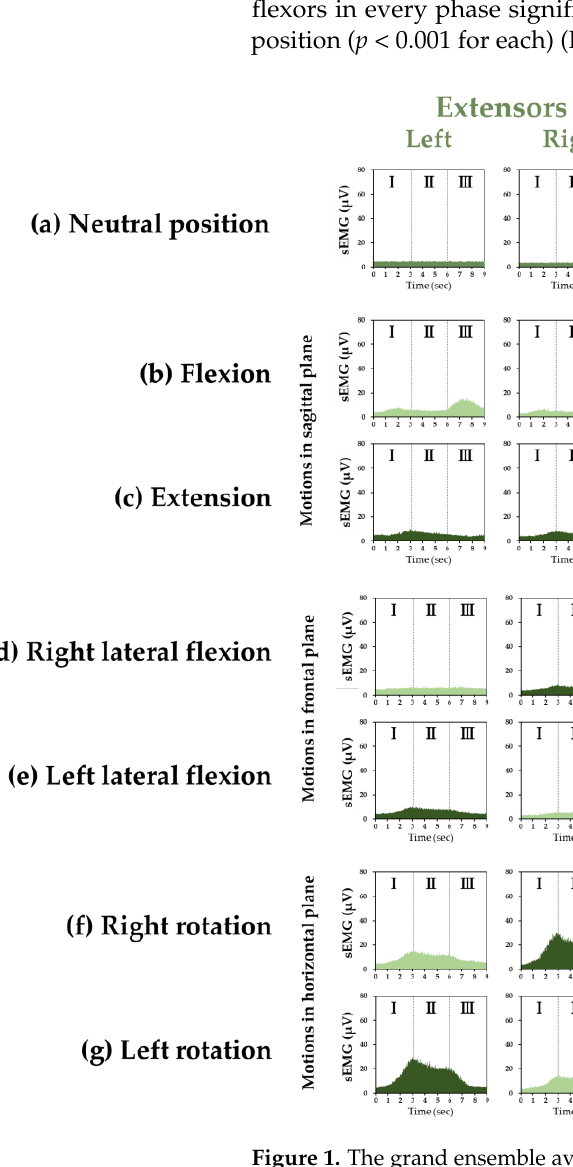
Figure 1. The grand ensemble average of surface electromyography (sEMG) of the cervical extensors and flexors in ( a ) the neutral position and during ( b ) flexion, ( c ) extension, ( d ) right lateral flexion, ( e ) left lateral flexion, ( f ) right rotation, and ( g ) left rotation. “I” indicates “Phase I”, a period (of three seconds) during a motion from the neutral position to the maximum range of motion. “II” indicates “Phase II”, a period (of three seconds) while maintaining the neck at the maximum range of motion. “III” indicates “Phase III”, a period (of three seconds) during a motion from the maximum range of motion to the neutral position. ( b , c ) show motion in the sagittal plane, ( d , e ) show motion in the frontal plane, and ( f , g ) show motion in the horizontal plane. The vertical and horizontal axes represent muscle activity and time, respectively. In ( a ) and in all the motions, the greenish color indicates the extensors and the brownish color indicates the flexors. In each motion, dark green indicates the ipsilateral extensors and dark brown indicates the ipsilateral flexors; light green indicates the contralateral extensors and light brown indicates the contralateral flexors.